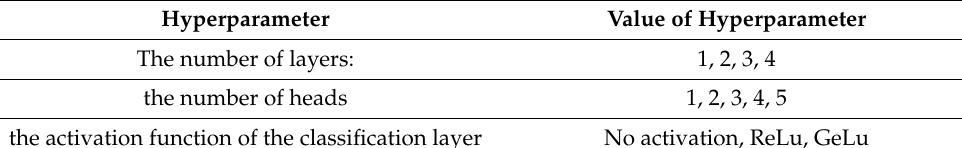
Table 1. Hyperparameter sets of